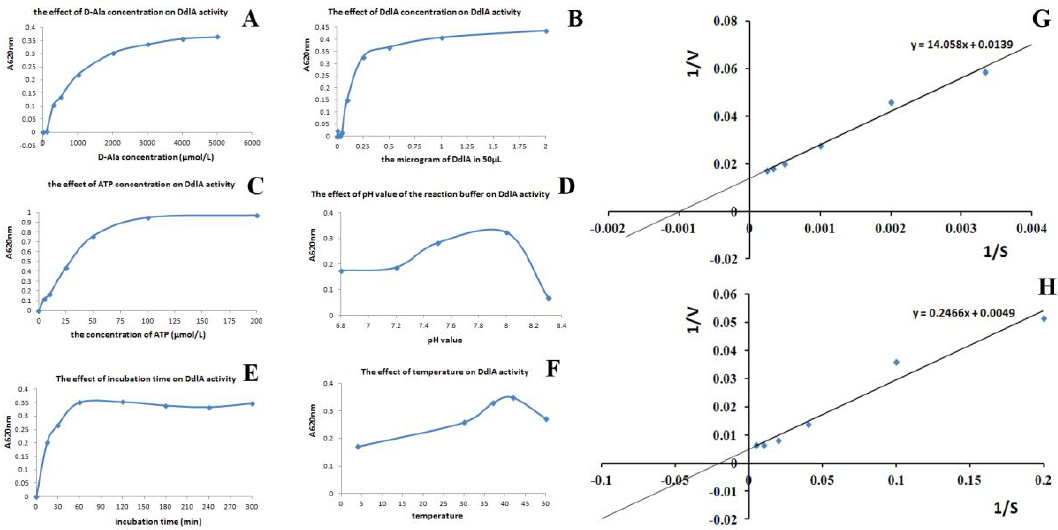
Figure 4. Determination of optimal reaction conditions for Mtb DdlA activity assay. ( A – F ) represented the effect of alanine concentration, DdlA concentration, ATP concentration, pH, incubation time, and temperature on the enzyme activity respectively; ( G ) The effect of alanine concentration on Tb -DdlA activity analyzed by the double reciprocal plot; ( H ) The effect of ATP concentration on Tb -DdlA activity analyzed by the double reciprocal plot.